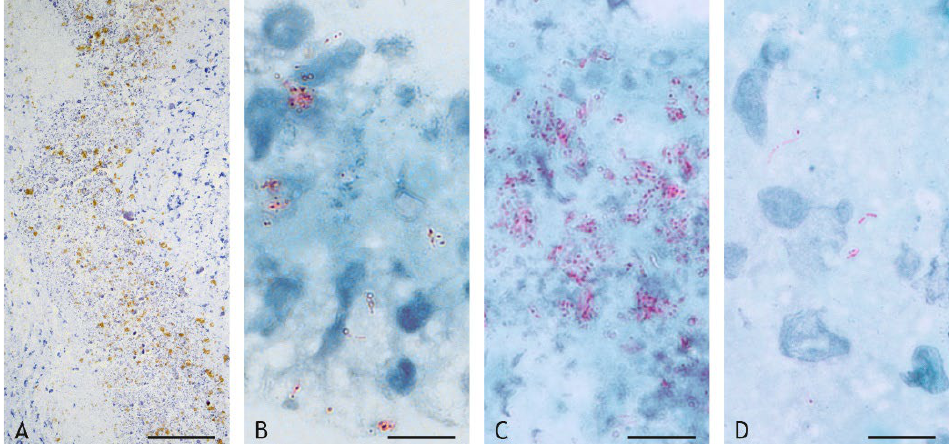
Figure 16. Mycobacterial antigen (brown) and acid-fast bacilli (AFB, red) in the central necrosis ( A – C ) and in the inflammatory infiltrate ( D ). ( A ). Patchy distribution of mycobacterial antigens (brown) in the central necrosis (goat 20, NOUG). ( B , C ): Number of AFB (red) in the central necrosis varies markedly between individuals (B, goat 13, BCG; C, goat 20, NUOG). ( D ). Few AFB (red) are present in epithelioid cells of the inflammatory infiltrate (D, goat 20, NUOG). ( A ). IHC, mycobacterial antigen, scale bar = 100 µm; ( B – D ). Ziehl–Neelsen (ZN) stain, scale bars = 10 µm.